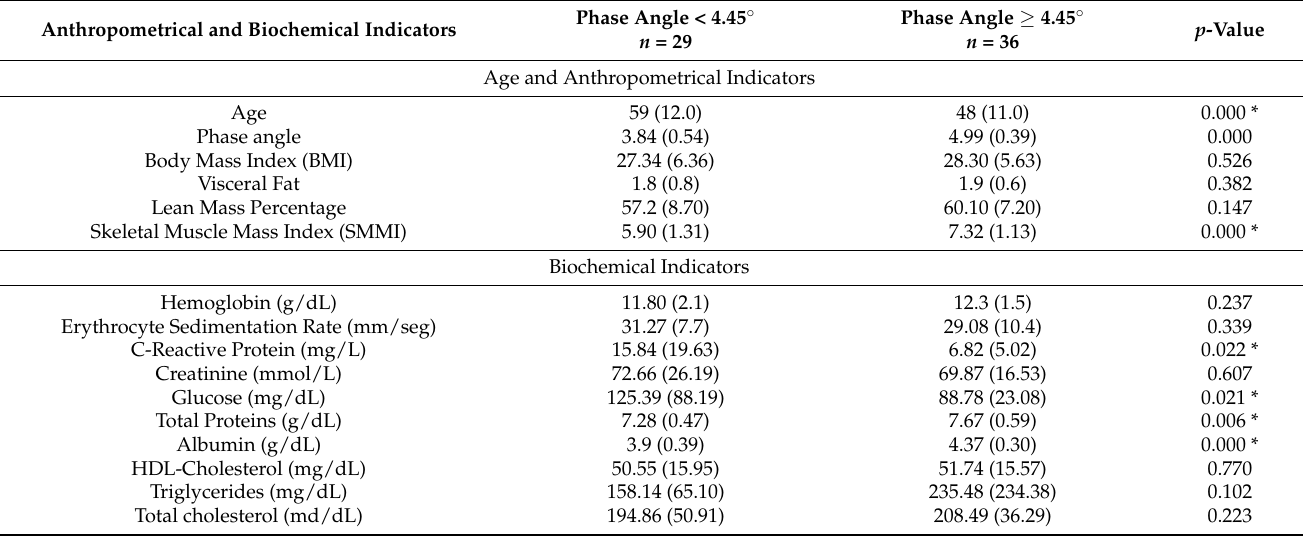
Table 2. Comparison of the anthropometric and biochemical parameters between uterine cervical cancer patients with low PA and normal